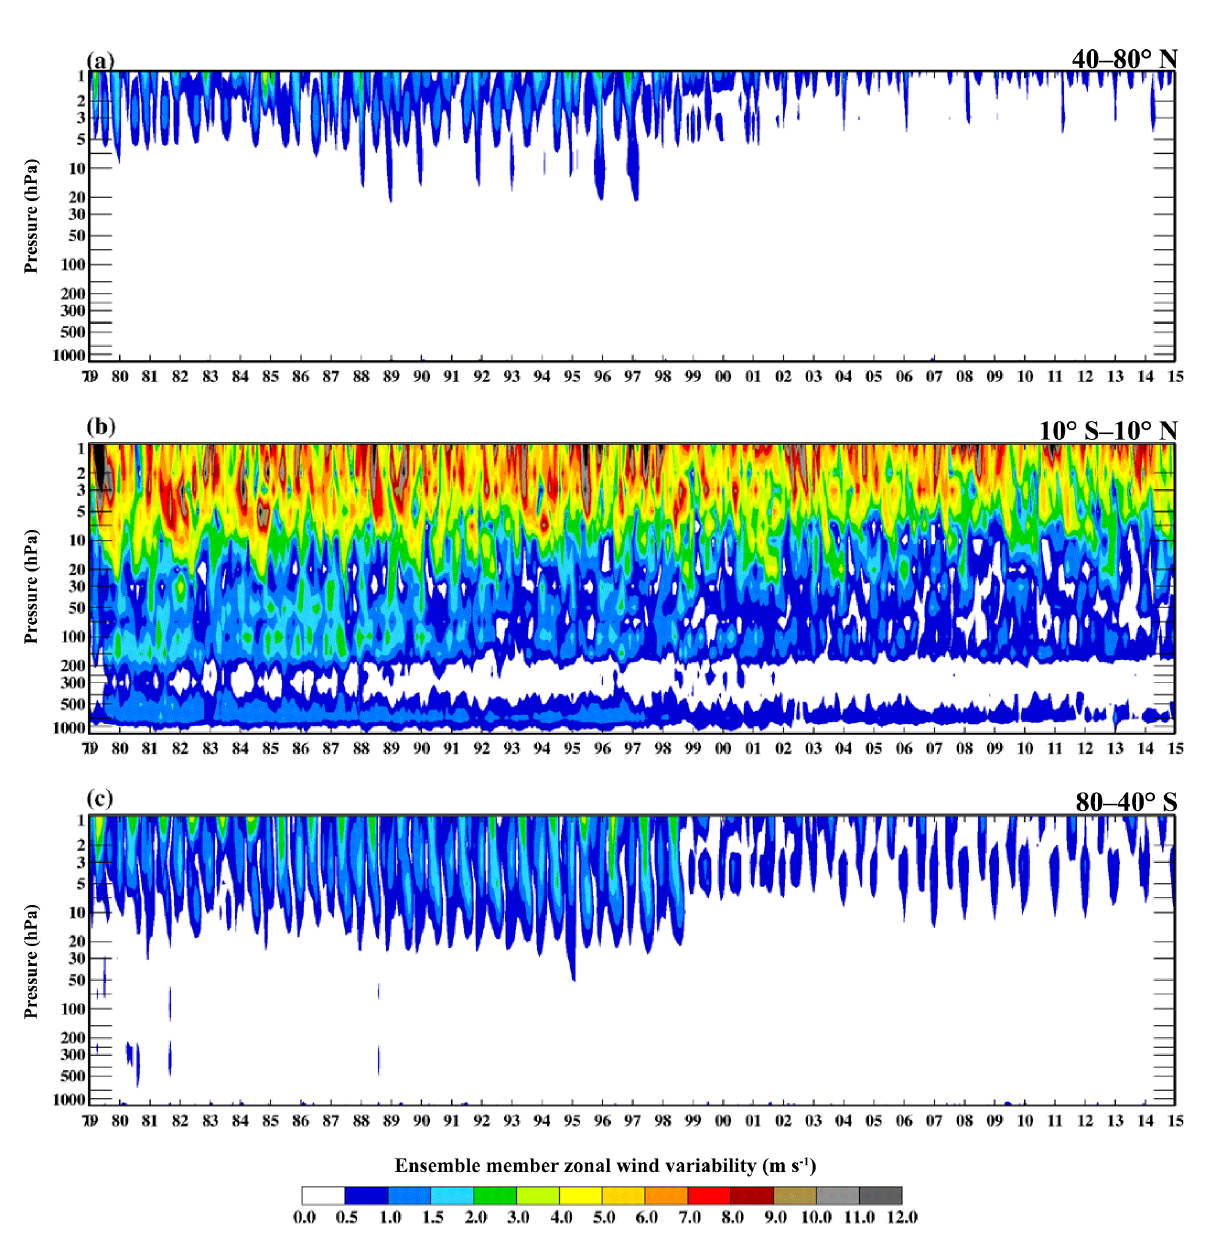
Figure 5. Pressure vs. time plots of the zonal wind SD (ms − 1 ) for each month of the three reanalyses making up the REM for three zonal regions: 40–80 ◦ N (a) , 10 ◦ S–10 ◦ N (b) , and 80–40 ◦ S (c)